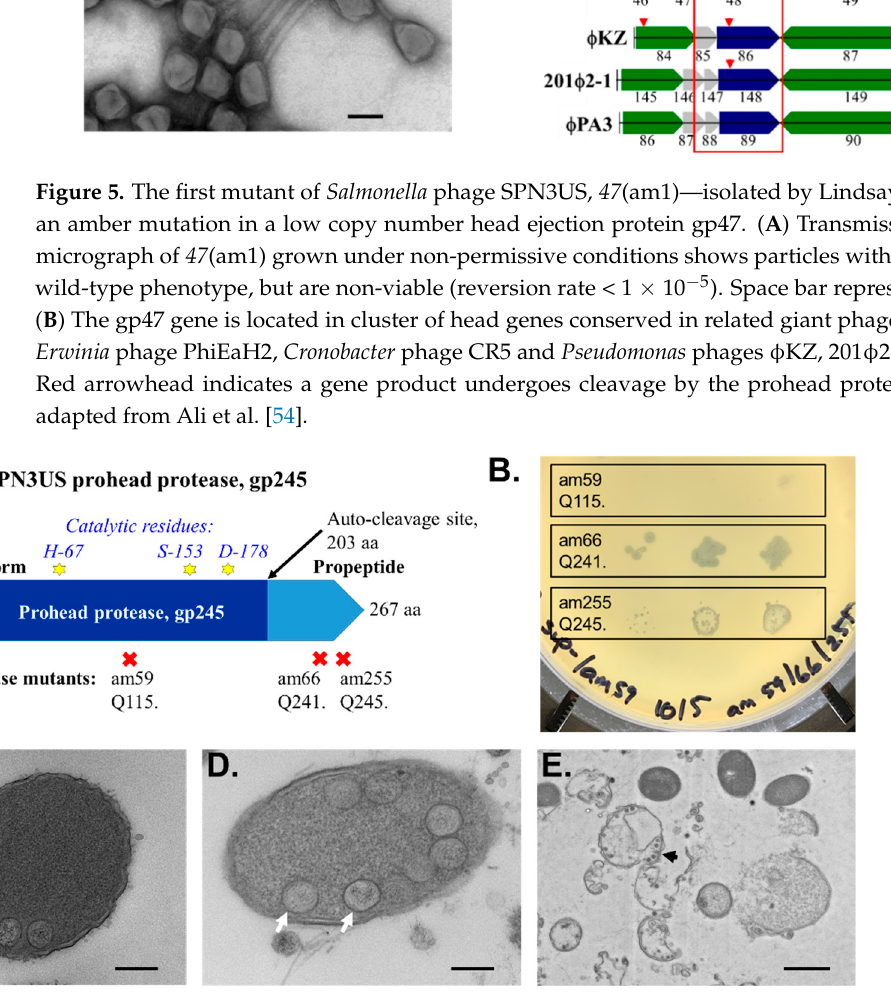
Figure 6. Proteolytic cleavage of head proteins by the prohead protease is essential for head matu- ration in Salmonella phage SPN3US. ( A ) Scheme of the SPN3US prohead protease gp245 showing the locations of catalytic residues. ( B ) Cross-plating of SPN3US protease mutants spotted on a lawn of a non-permissive strain seeded with mutant am59, showing complementation (intragenic recom- bination) with am66 and am255. ( C – E ) Electron microscopy of thin sections of a non-permissive strain of Salmonella infected with ( C ) the wild-type phage at 10 min post-infection and ( D , E ) am59 at 90 min post-infection. Examples of proheads attached to the host inner membrane are indicated with white arrows. ( E ) In the absence of proteolysis, proheads were observed still attached to the inner membrane after cell lysis (black arrow), which was delayed relative to normal. Space bar rep- resents 200 nm ( C , D ) and ( E ) 1 µm.